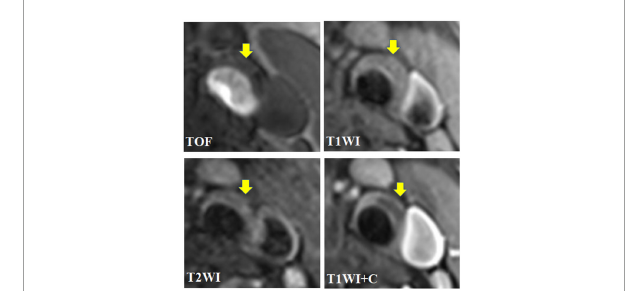
FIGURE2 A 67 year-old male presented with intermittent dizziness for 2 weeks. The transverse axial TOF-MRA showed mild stenosis of left common carotid artery and bifurcation with local plaque formation, and the plaque was isointense; HR-MRI axial T1WI showed that the left carotid plaque was isointense; HR-MRI axial T2WI showed low signal in the left carotid plaque and isosignal on the plaque surface; HR-MRI axial T1WI enhancement showed that the surface of left carotid artery plaque showed obvious zonal enhancement, but no enhancement was found in the plaque; To sum up, the plaque components of the left common carotid artery and its bifurcation are the core of lipid necrosis, and the surface fiber cap is intact, which belongs to AHA type